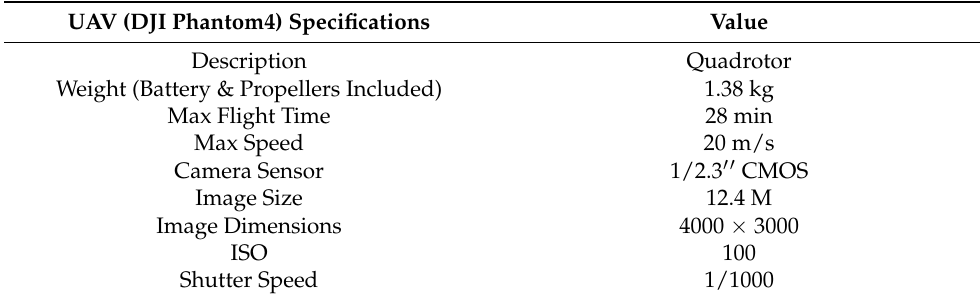
Table 1. The specifications of the UAV and the airborne